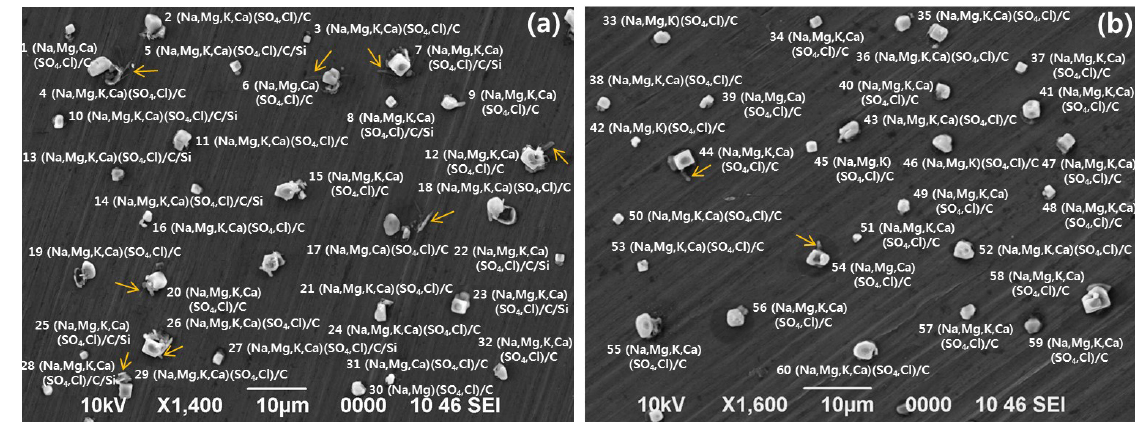
Figure 1. Typical secondary electron images (SEIs) of aerosol particles at stages 2 of the austral (a) summertime and (b) wintertime samples collected at King Sejong station, Antarctica.